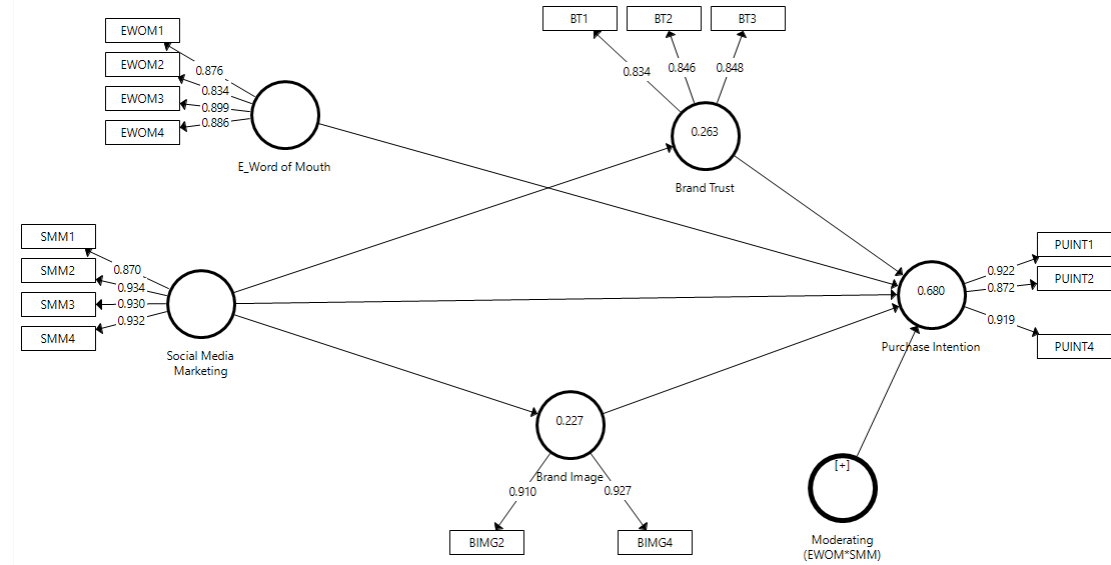
Fig. 2. The results of the outer loading coefficients for the measurement model